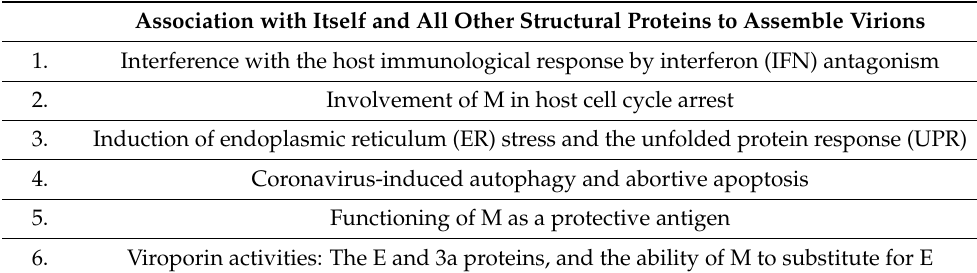
Table 3. Potential Functions of Coronavirus Matrix (M)